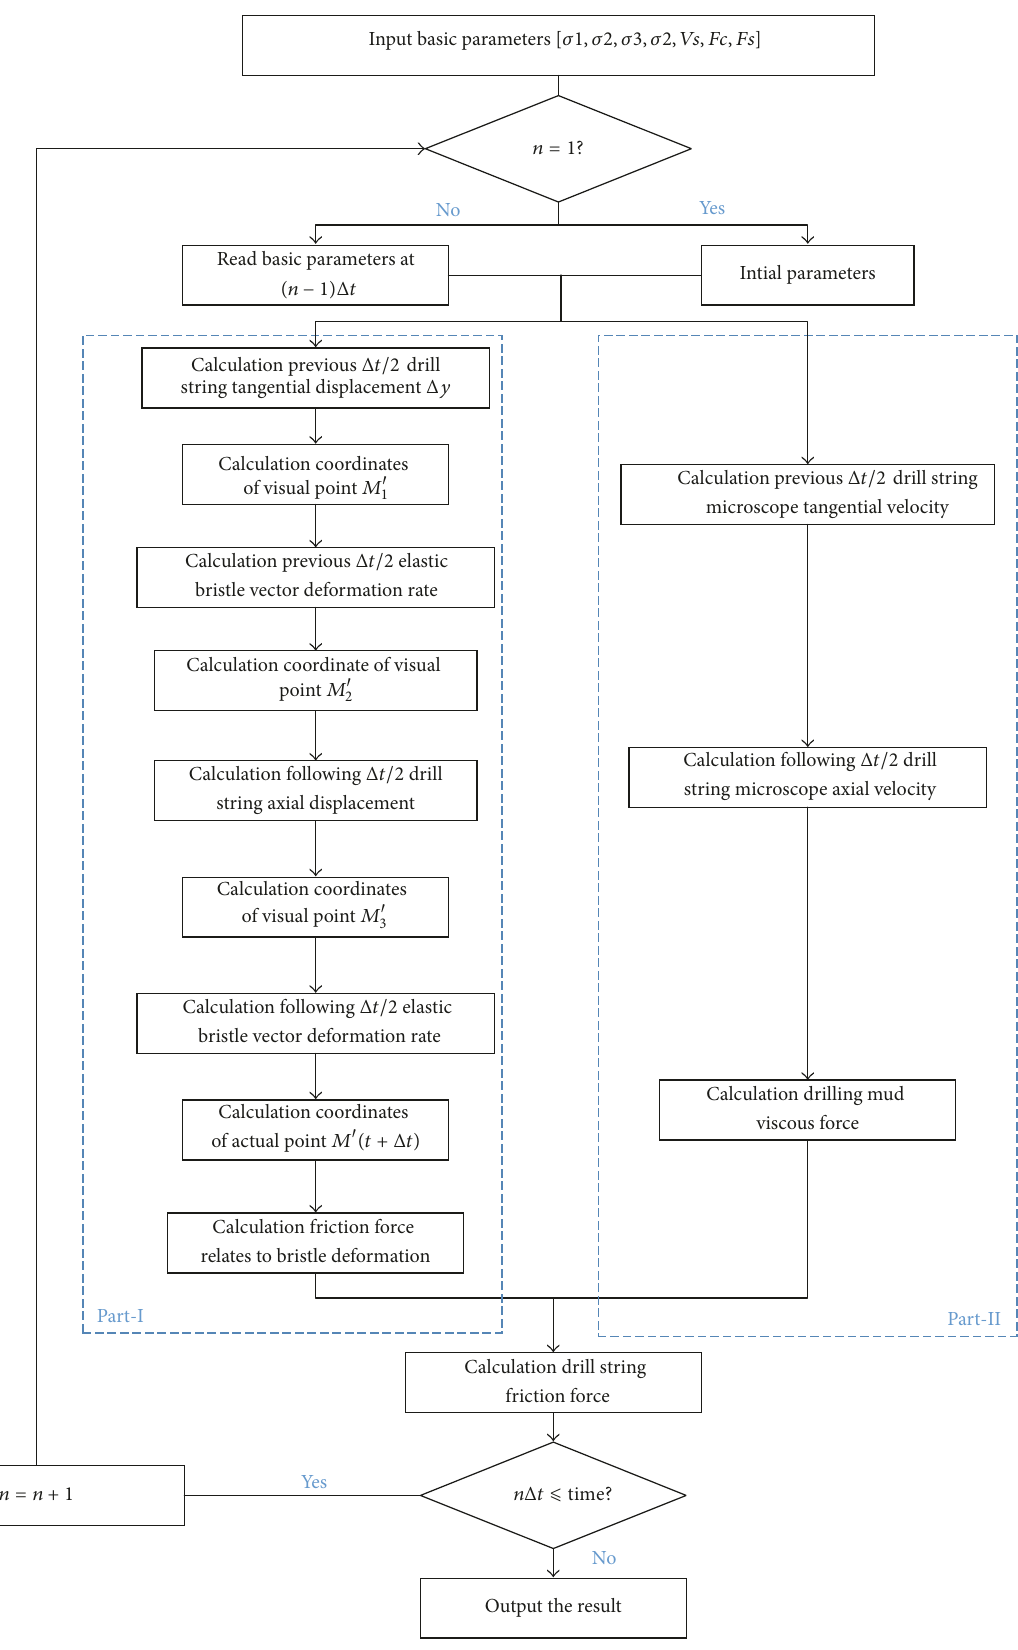
Figure 5: Present model solution flow